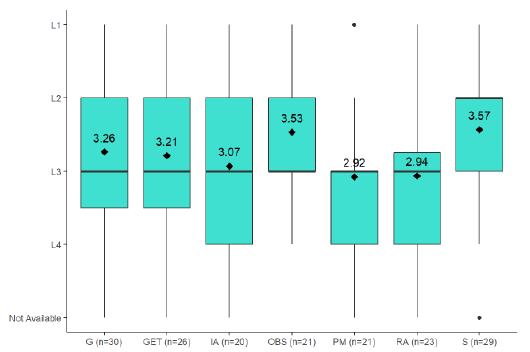
Figure 5 . Comparing state DOTs’ usage of different Data Levels of Detail across the different assets of the Roadside Asset Systems.